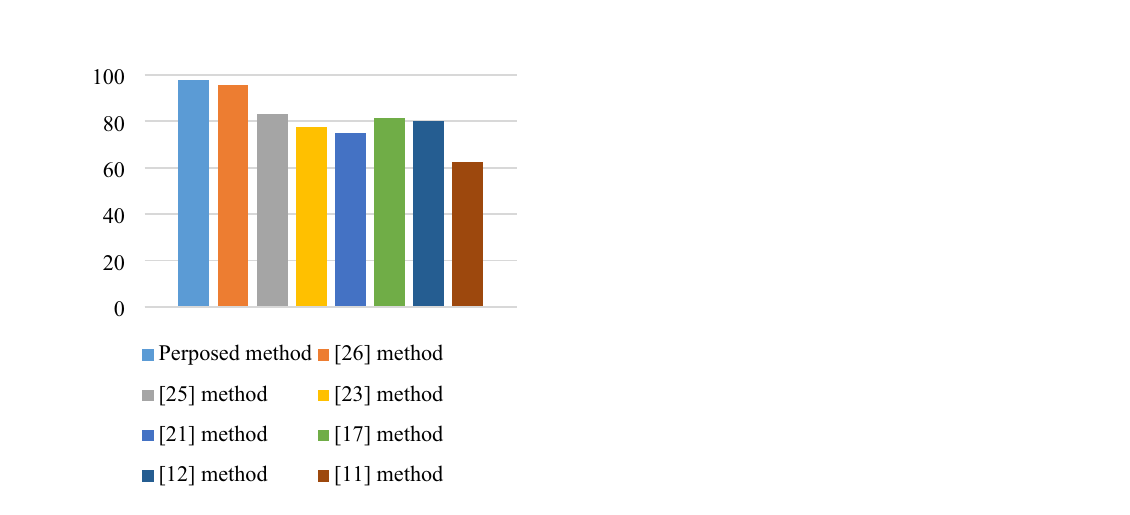
Figure 10. Subject-independent scenario accuracy of the proposed method as well as the methods presented in 11,12,17,21,23,25,26 for recorderd